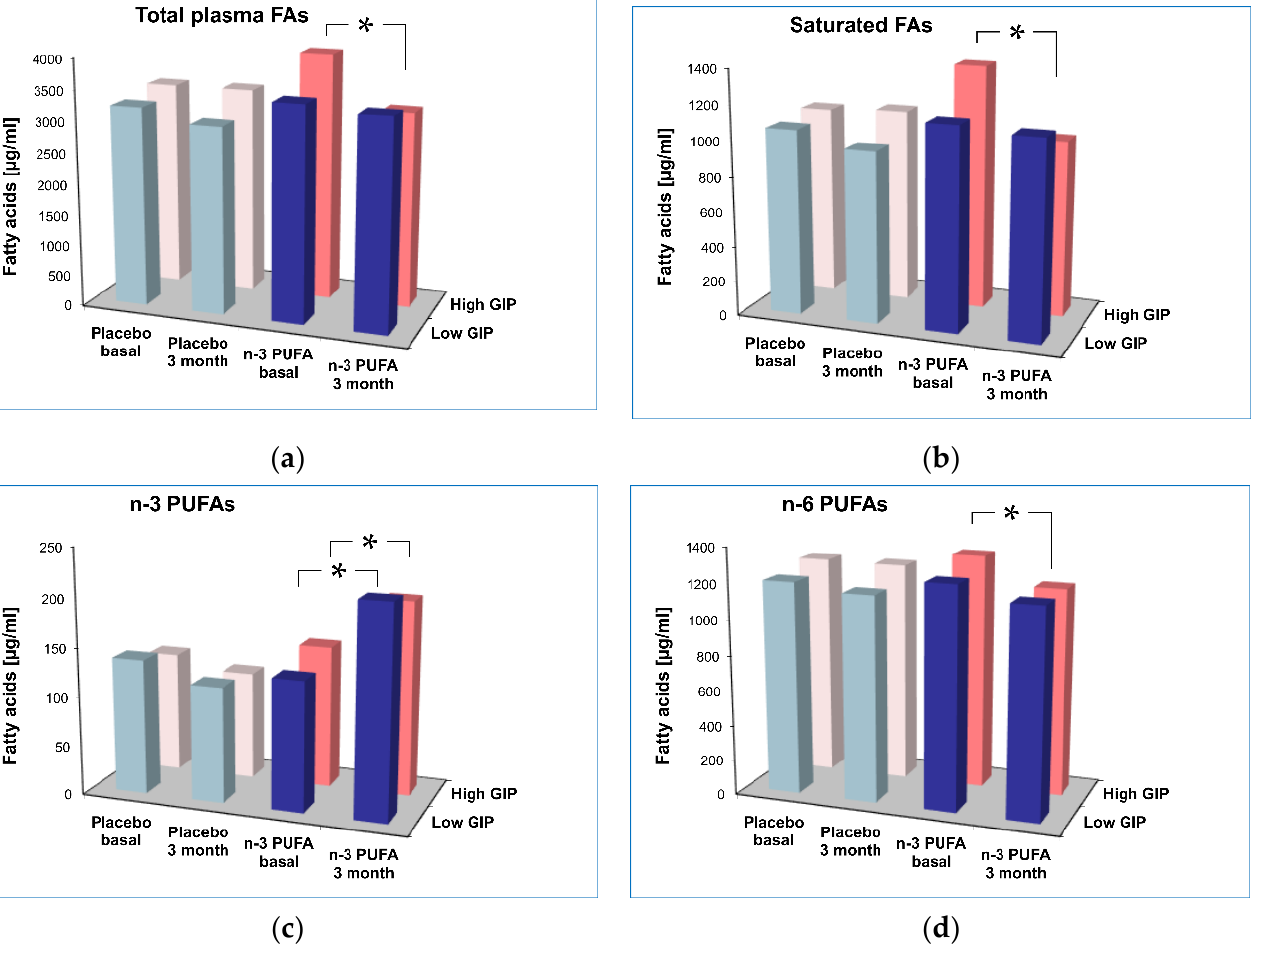
Figure 3. The effect of n-3 PUFA supplementation on total plasma fatty acids ( a ), saturated FAs ( b ), n-3 PUFAs ( c ) and n-6 PUFAs ( d ). * p < 0.01 significant change after 3-month intervention vs. baseline.